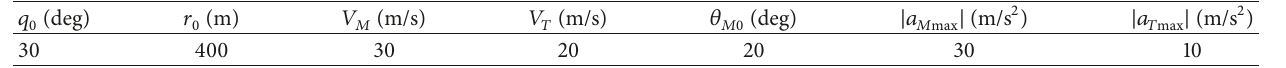
Table 1: Initial parameters for guidance